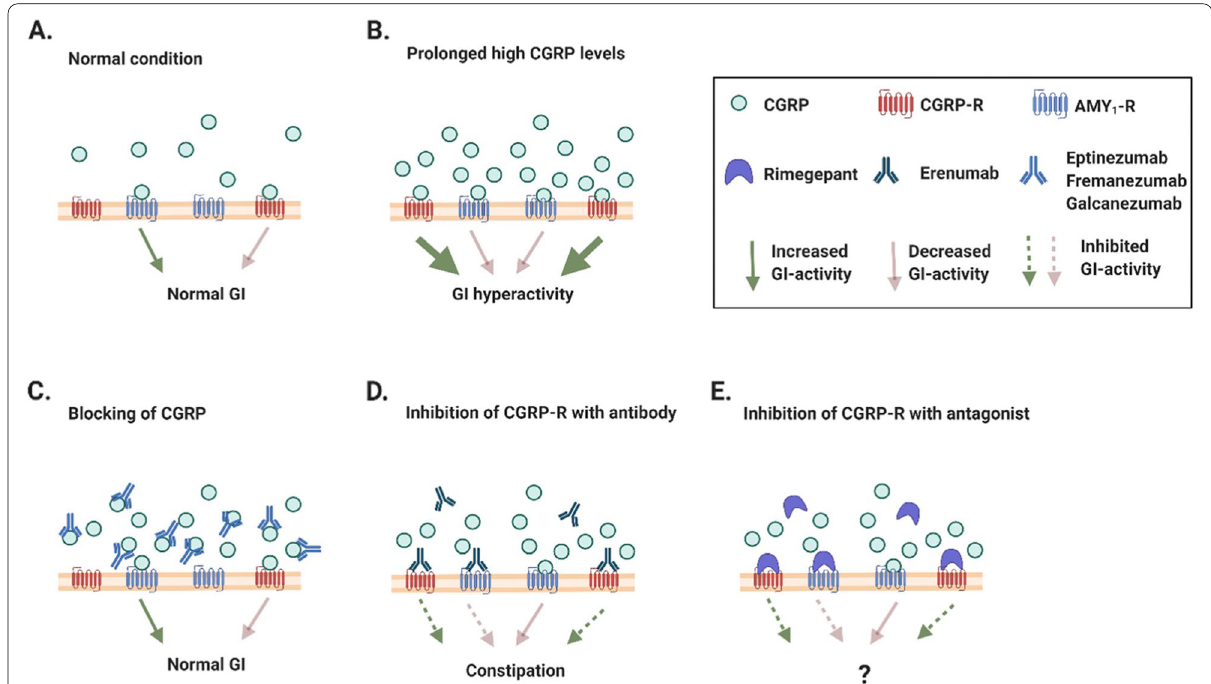
Fig. 7 Schematic overview of the suggested role of CGRP and its antagonists in the gastrointestinal (GI) system. A Shows the normal situation with a low amount of free CGRP to stimulate the receptors B In a situation with high CGRP levels as described in [38] the CGRP molecules will bind to both CGRP‑R and AMY 1 ‑R. The higher affinity of CGRP to the CGRP‑R leads to GI hyperactivity as observed during infusion of CGRP for 2 hrs [38]. In C inhibition of the CGRP molecules with monoclonal antibodies (e.g. Eptinezumab, Fremanezumab or Galcanezumab) is shown. Less free CGRP leads to a lower binding rate of CGRP to CGRP‑R and AMY 1 ‑R. The balance between signaling from CGRP‑R and AMY 1 ‑R is intact and neither GI‑hyperactivity nor constipation is found. D Treatment of patients with erenumab a monoclonal antibody directed towards the CGRP‑R, prevents binding of CGRP to the CGRP‑R. Erenumab can to some extent also block the AMY 1 ‑R. However, some CGRP molecules still binds to the free AMY 1 ‑R. This situation causes an imbalance of CGRP signaling in the GI system with a larger inhibition of CGRP’s stimulating effect on CGRP‑R than CGRP’s antagonistic effect on AMY 1 ‑R. It should be noted that some of the AMY 1 ‑R mediated effects on the GI‑system can be secondary via receptors in area postrema. The overall effect is constipation, which has been reported during treatment with erenumab [30, 31]. E Future Real‑World studies will reveal to what extent constipation occurs after treatment with small molecule antagonists such as Rimegepant. According to the results of the present study a similar pattern as described in C seems